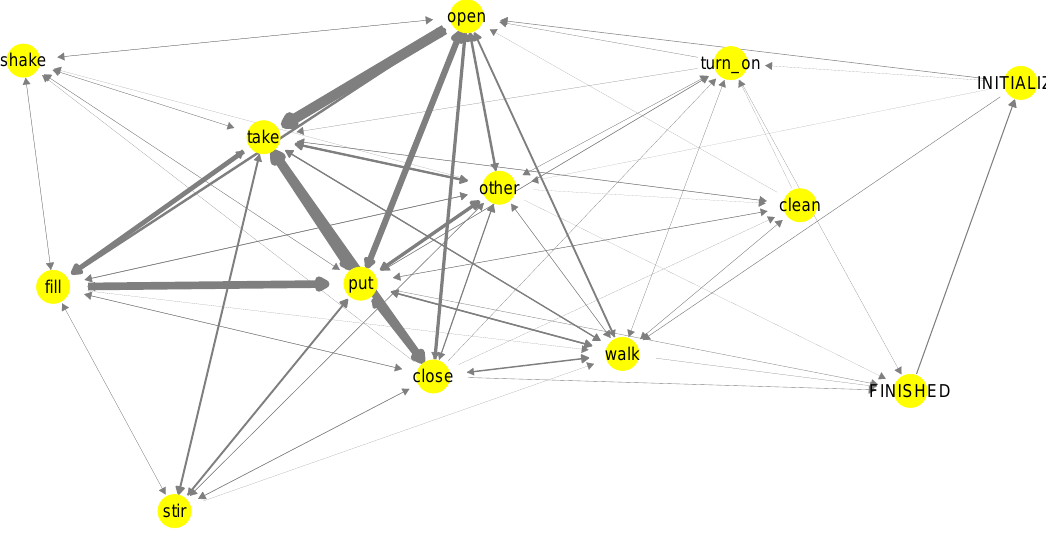
Figure 8. Graph representing the causally correct transitions between action classes. Thicker arrows indicate more probable transitions. Note that, besides the action classes from Table 4, we also have initial and finish actions marking the initial and goal conditions of the model.